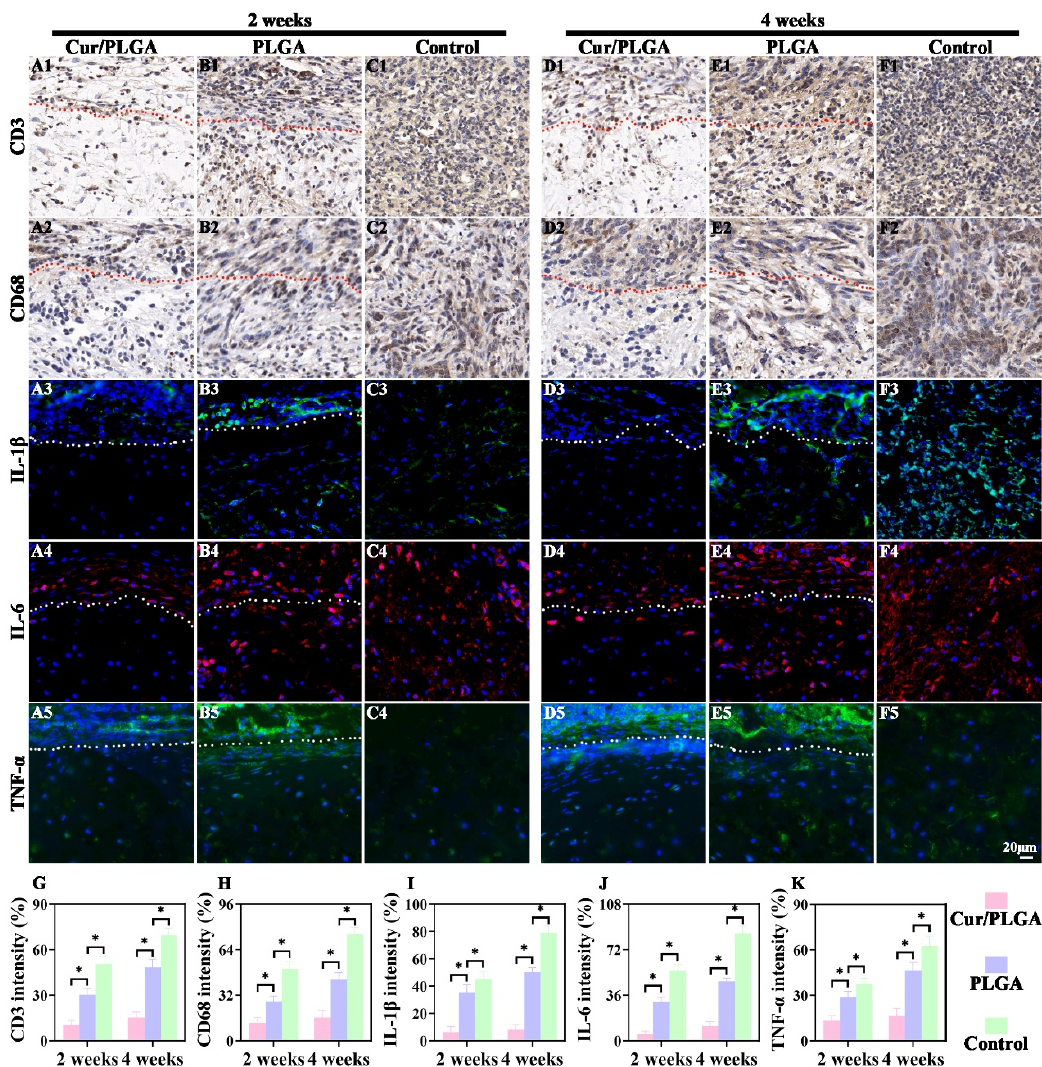
Figure 7. Anti-inflammatory effects of the curcumin/poly(lactic-co-glycolic acid) (Cur/PLGA) nanofibrous membrane at weeks 2 and 4 after subcutaneous implantation in rats: CD3 immunohistochemical staining of samples in the Cur/PLGA, PLGA, and control groups ( A1 – F1 ). CD68 immunohistochemical staining of samples in the Cur/PLGA, PLGA, and control groups ( A2 – F2 ). IL-1 β immunofluorescence staining of samples in the Cur/PLGA, PLGA, and control groups ( A3 – F3 ). IL-6 immunofluorescence staining of samples in the Cur/PLGA, PLGA, and control groups ( A4 – F4 ). TNF- α immunofluorescence staining of samples in the Cur/PLGA, PLGA, and control groups ( A5 – F5 ). Relative staining intensities of CD3, CD68, IL-1 β , IL-6, and TNF- α in the Cur/PLGA, PLGA, and control groups ( G – K ). The dotted red and white lines outline the nanofibrous membrane, and the lower region represents the cartilage. * p < 0.05.